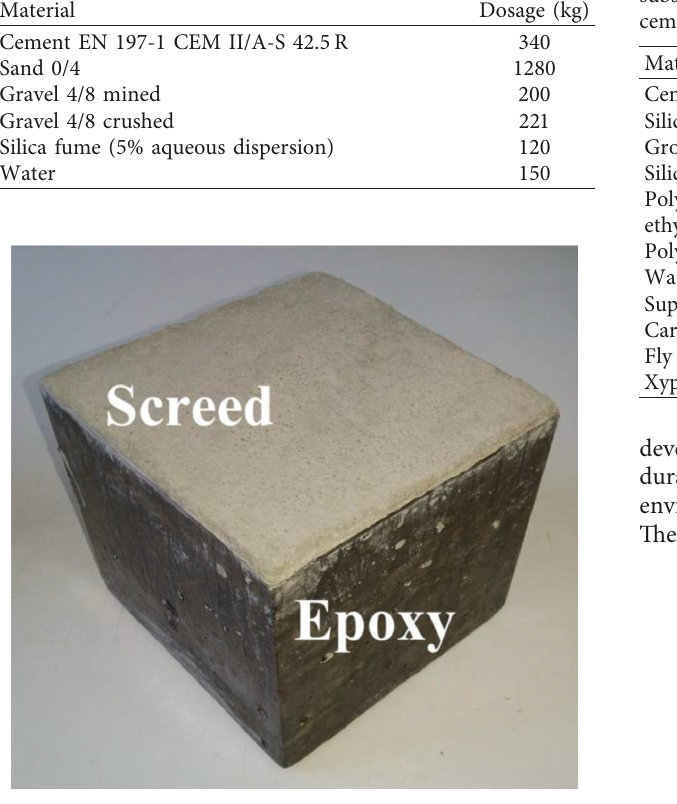
Figure 2: Concrete specimen with the screed applied on the face and epoxy coating on remaining sides of concrete Table 2: Composition of polymer cement coating (CT).